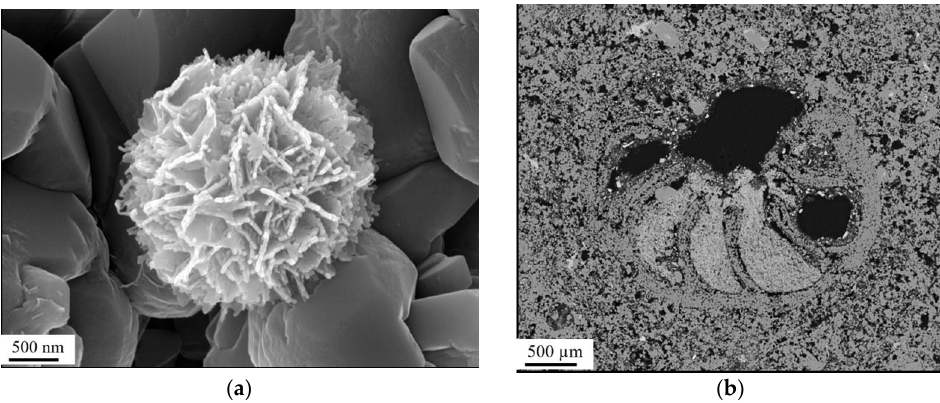
Figure 3. ( a ) SEM micrograph taken with the use of a SE-detector. The imaged object is an opal-CT lepisphere found in Aalborg chalk. ( b ) SEM micrograph of a foraminifera fossil found in chalk from Liège using BSE. The different grey-scales reflects the average atomic number (AAN) of each phase, thereby separating different mineralogical composition.